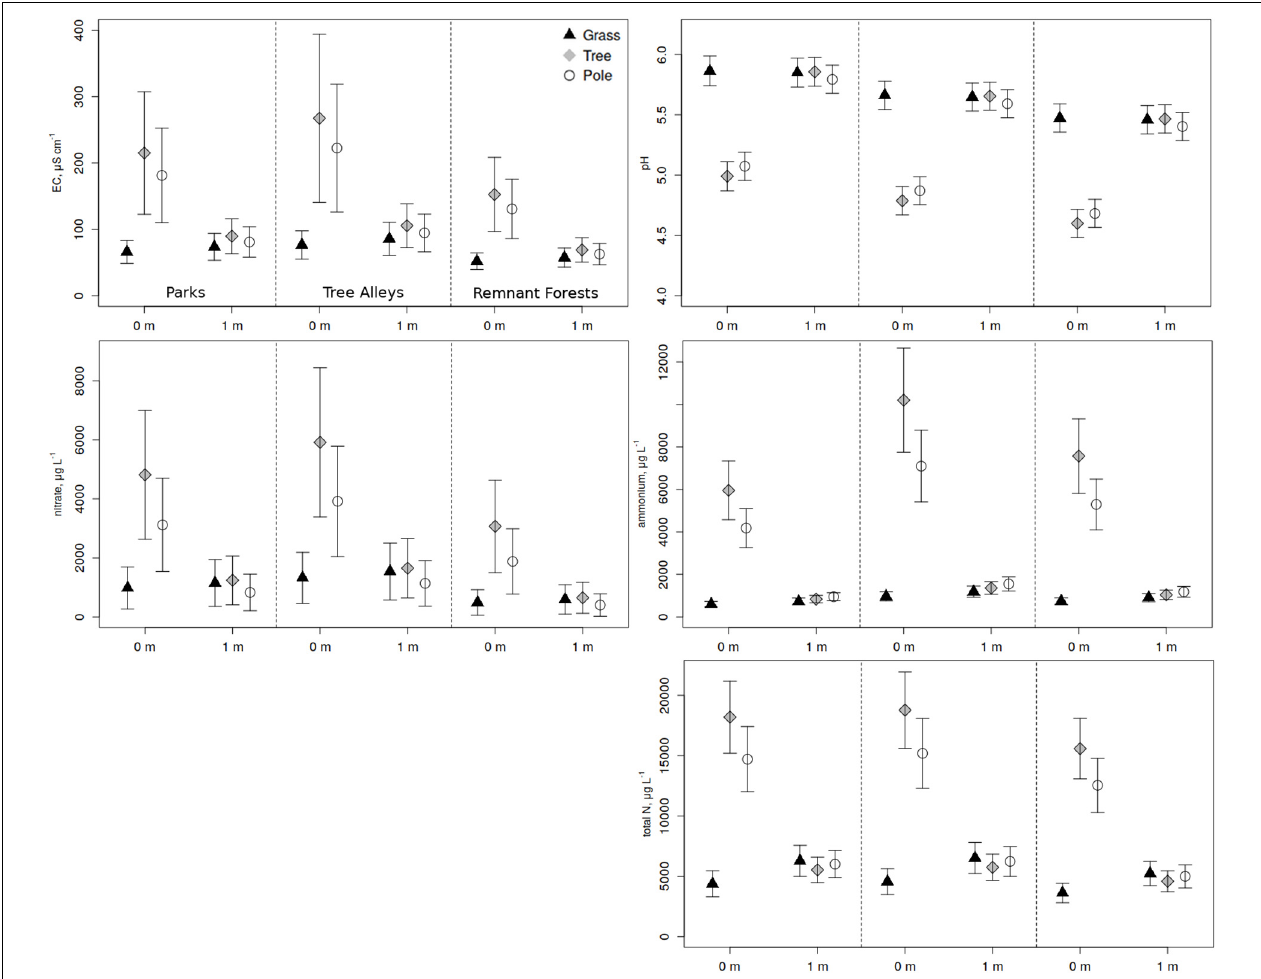
FIGURE 2 | Comparison of back-transformed model predicted mean ± SE values for Electrical Conductivity (EC), pH, nitrate, ammonium, and total nitrogen at 0 and 1 m away from path-side grass plots, trees, and poles in three greenspace typologies: Parks, Tree Alleys and Remnant